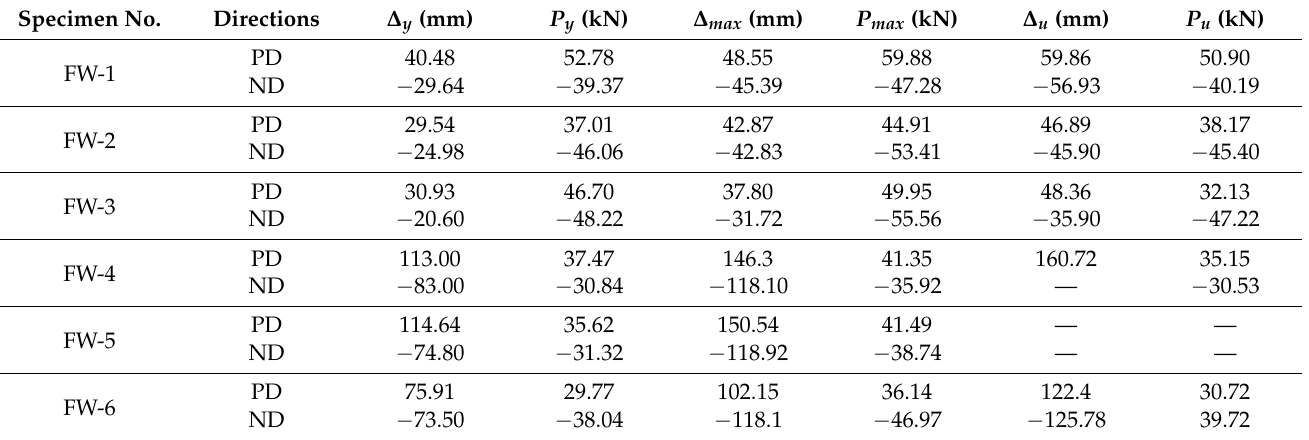
Figure 14. Illustration of the equivalent energy method [18]. Table 4. Load characteristics.